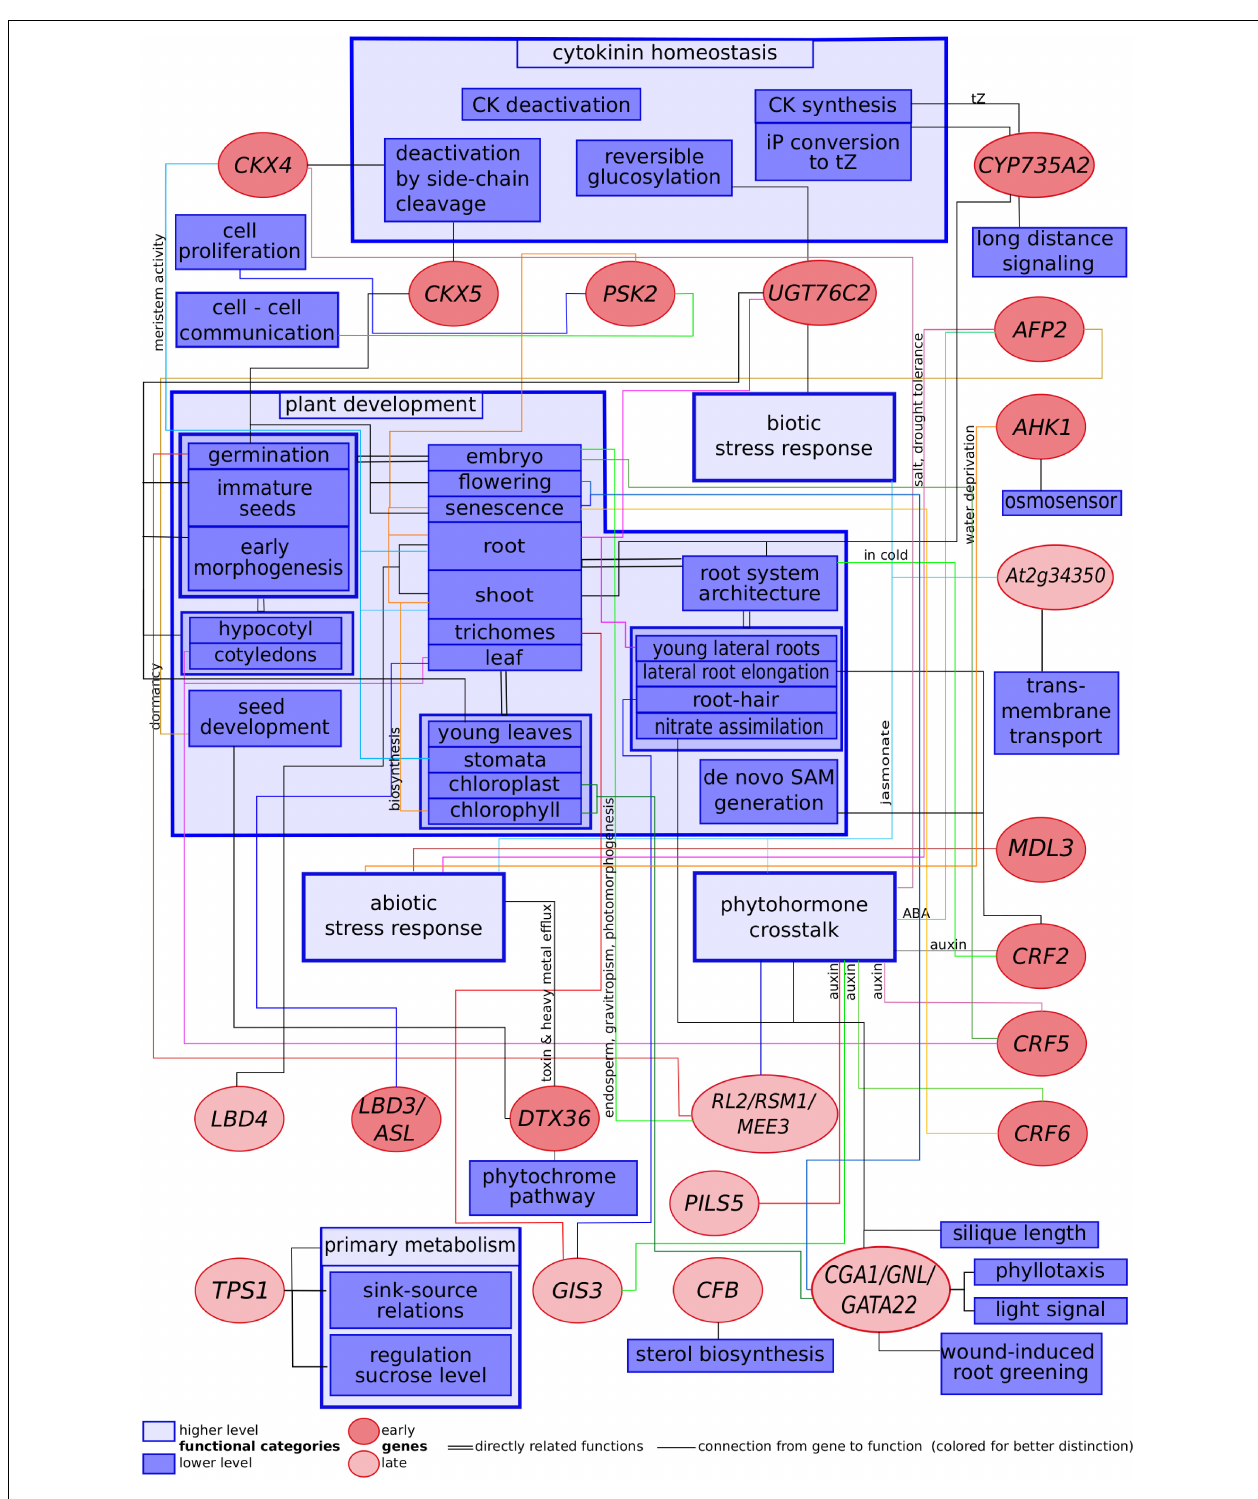
FIGURE 1 | Scheme showing selected cytokinin-regulated genes related to their functions described in published literature.